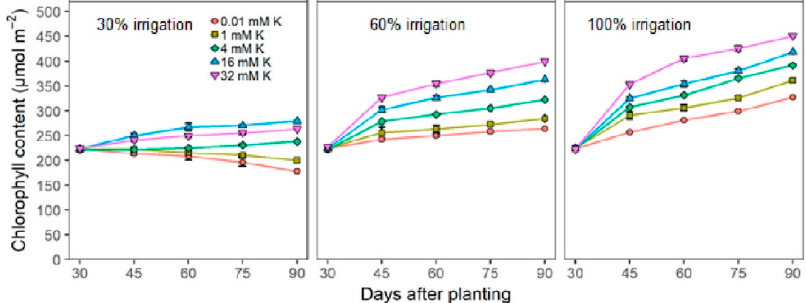
Figure 3. Leaf chlorophyll content of young cassava plants in response to deficit irrigation and K fertigation. Treatments were initiated 30 days after planting and lasted 60 days. The data from four separate experiments were combined and shown as the means ± standard error of 4 to 16 replicate plants.